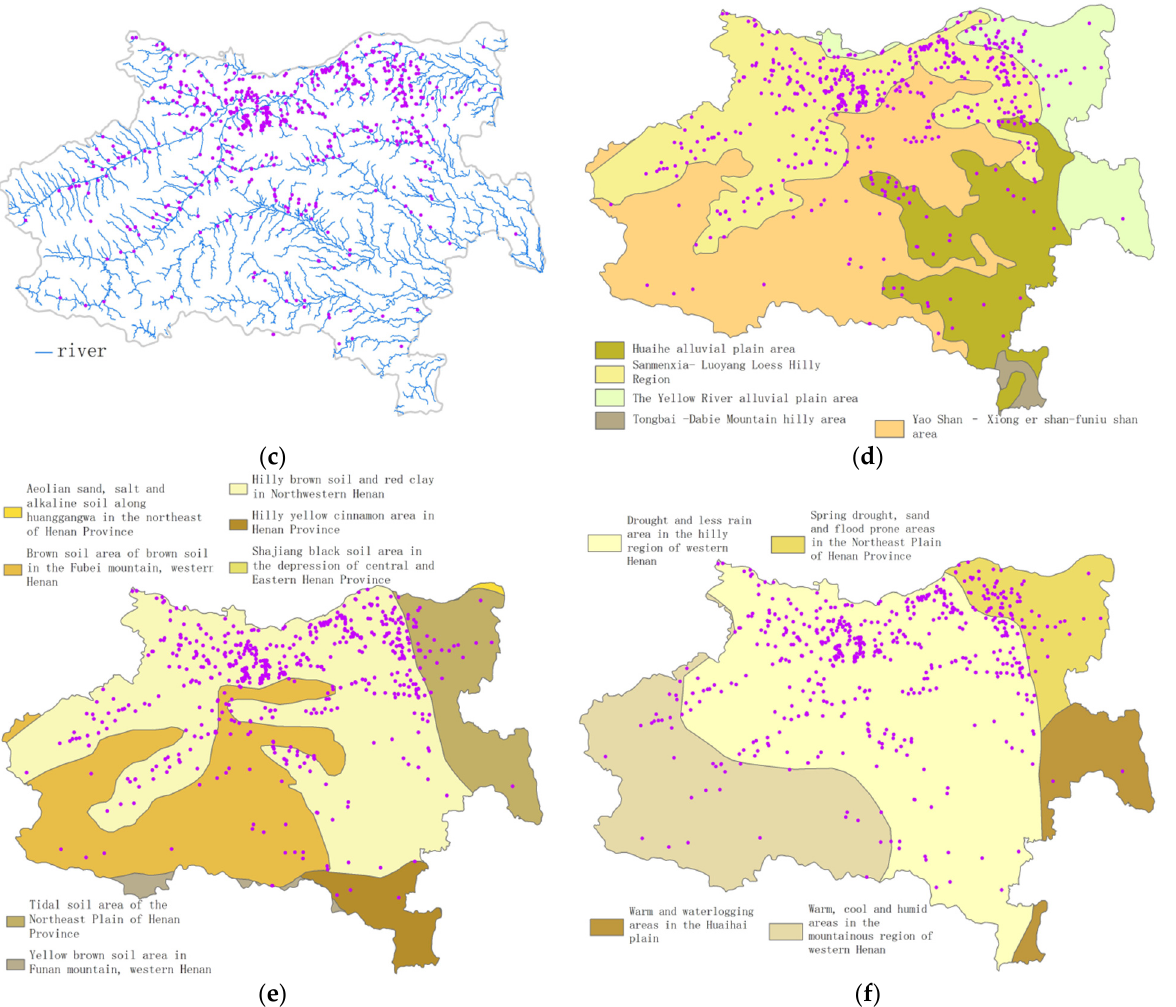
Figure 2. Overlay Map of Yangshao period settlements around Songshan with the parameters used in the model: ( a ) altitude; ( b ) slope; ( c ) rivers; ( d ) landforms; ( e ) soil; and ( f ) climate.